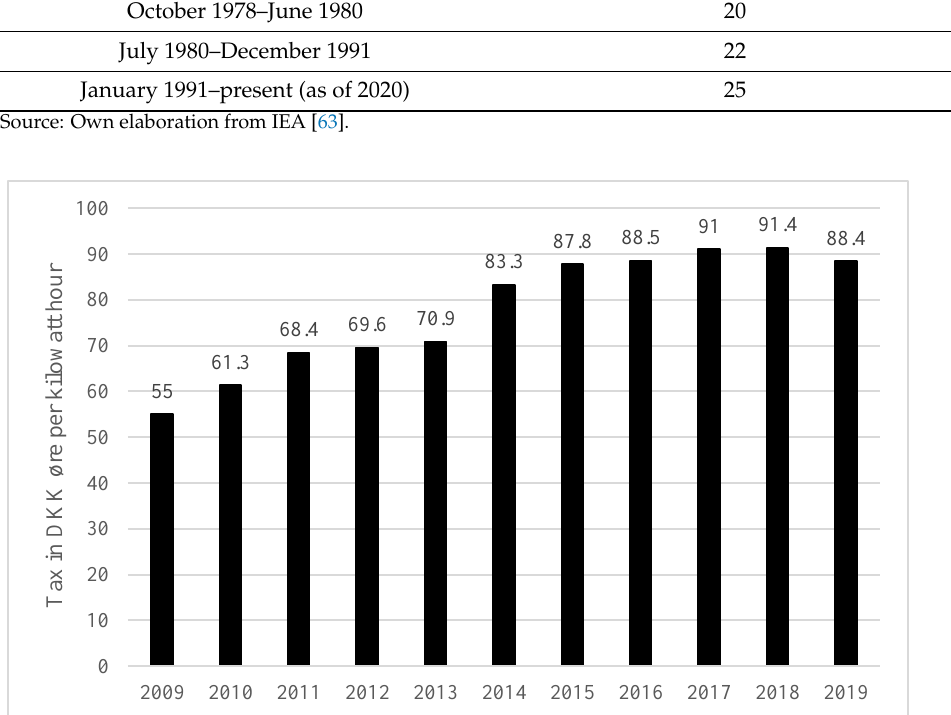
Figure 4. Denmark’s household electricity taxation, 2009–2019. Source: Statista [69]. Notes: tax in DKK per kilowatt